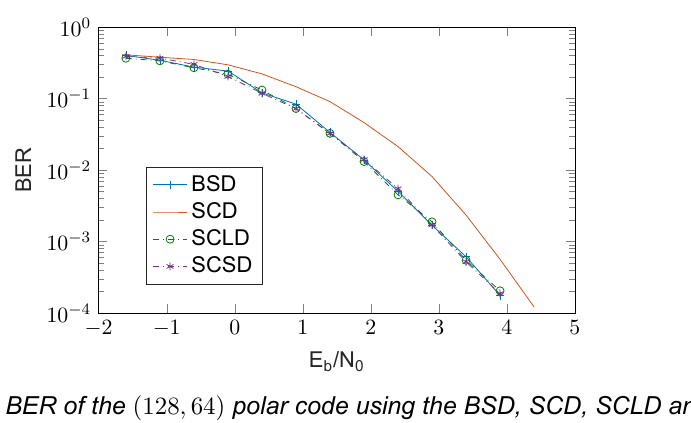
Figure 5 – BER of the (128 , 64) polar code using the BSD, SCD, SCLD and SCSD